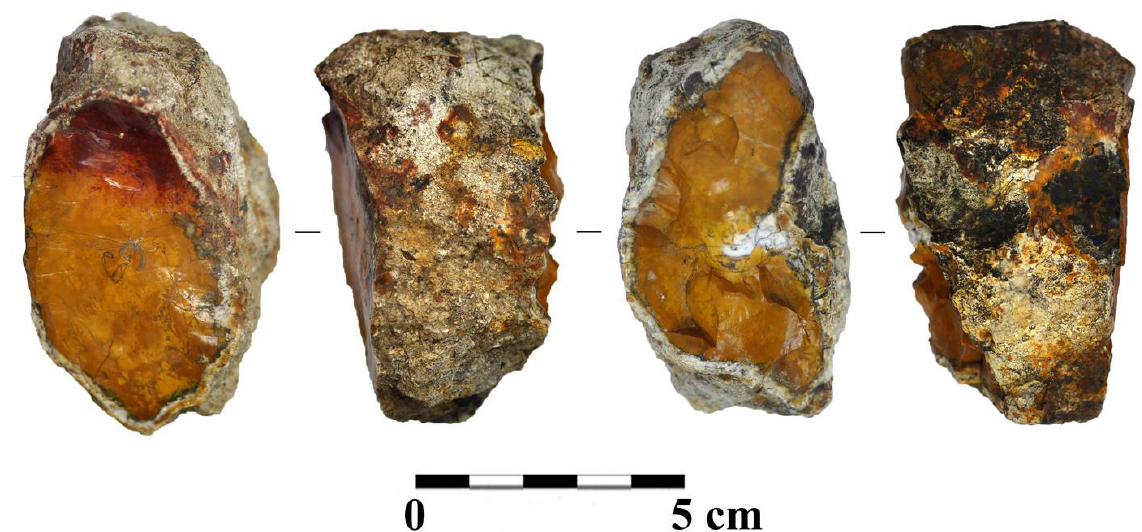
Figure 10. Lojanik 1, Cluster 1: sample 13, part of raw material from primary deposit.